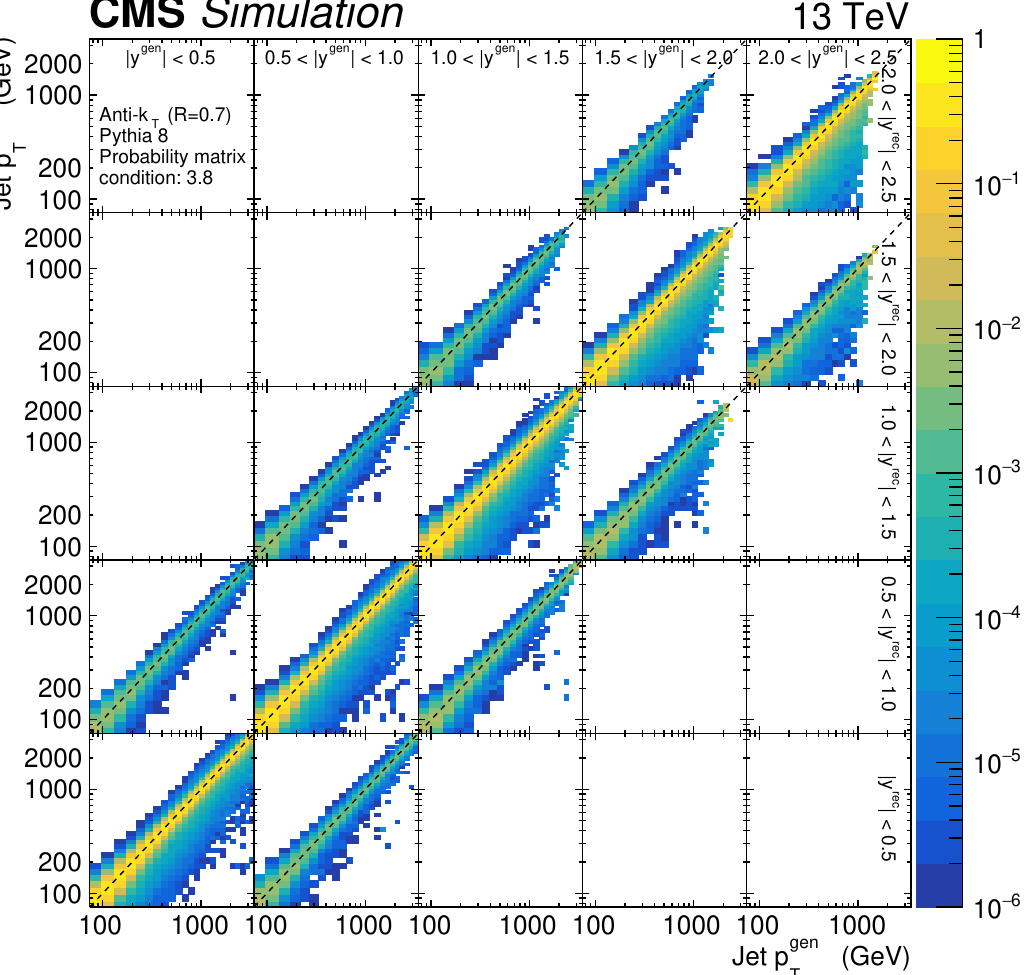
Figure 1 . The probability matrix, estimated with a simulated sample based on pythia 8, for jets clustered using the anti- k algorithm with R = 0 . 7 . The horizontal (vertical) axis corresponds to T jets at the particle (detector) level. The global 5 × 5 structure corresponds to the bins of rapidity y of the jets, indicated by the labels in the uppermost row and rightmost column; the horizontal and vertical axes of each cell correspond to the transverse momentum p of the jets. The colour range T covers a range from 10 − 6 to 1 and the rows are normalised to unity, indicating the probability for a particle-level jet generated with values of p gen and | y | gen to be reconstructed at the detector level T with values of p rec and | y | rec . Migrations outside of the phase space are not included; migrations T across rapidity bins only occur among adjacent rapidity bins. The dashed lines indicate the diagonal bins in each rapidity